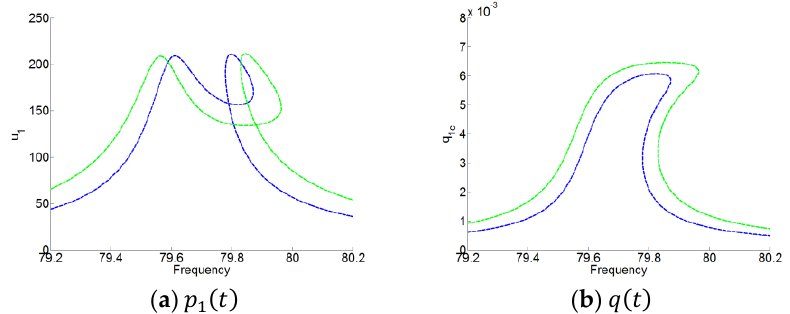
Figure 14. Responses of 𝑝 1 (𝑡) and 𝑞(𝑡) of the system for 𝐹 1 = 2.01 in blue curves and 𝐹 1 = 3.01 in green curves. Dashed curves stand for the responses of the system with the two modes 𝑃 010 and 𝑃 001 coupled by the membrane. Solid curves stand for the responses of the system only with the mode 𝑃 010 coupled by the membrane. ( a ) 𝑝 1 (𝑡) and ( b ) 𝑞(𝑡) .